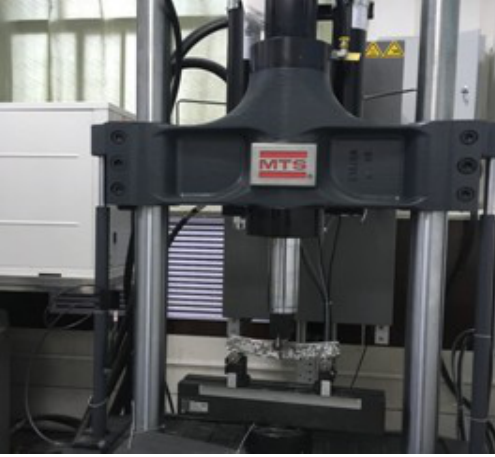
Figure 4. MTS Landmark (MTS 810). Table 5. Aggregate types and numbers of different asphalt